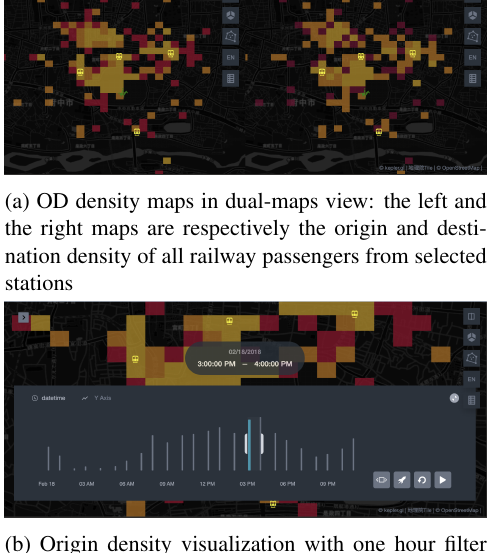
Figure 5. Visualization of density maps in the map panel sengers in the map panel. This map utilizes three layers to re- spectively visualize railway stations and horse racing fields in icon layers, and OD density in a Japanese Standard Mesh